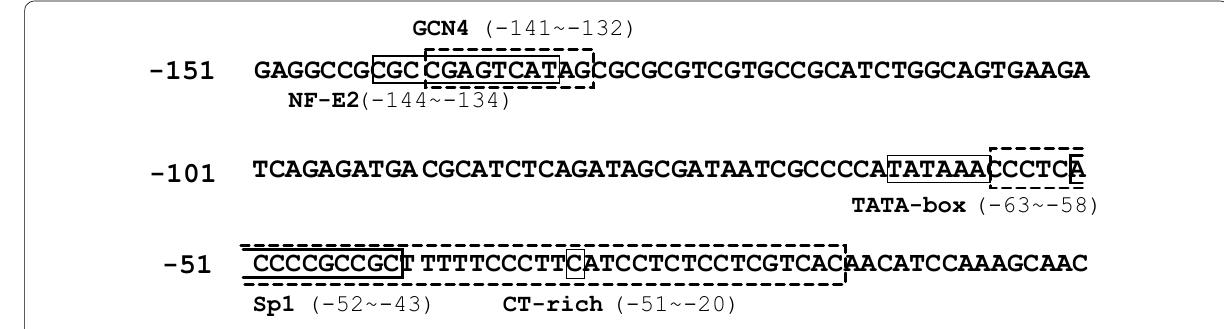
Fig. 5 Proposed transcriptional regulation sites in the minimal promoter region of Csgpd . Conserved motives mostly characterized in S. cerevisiae were found by an in silico motif search. The boxed C nucleotide at position EST